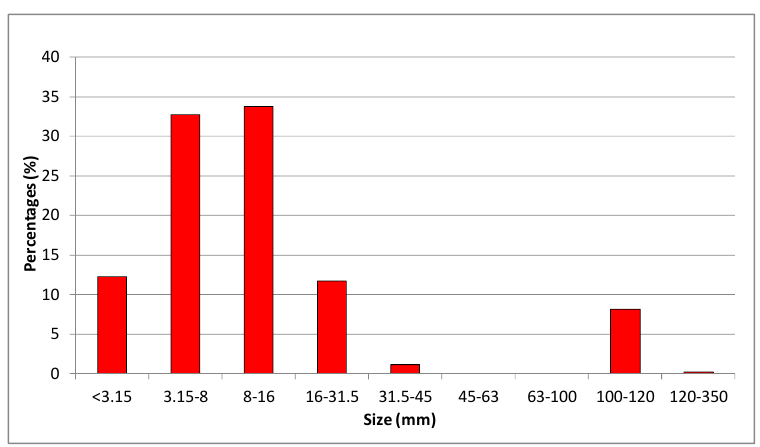
Figure 3. Particle size distribution analysis of the hog fuel produced by the Caravaggi mod. BIO900. The d50 value (median value of the cumulated distribution curve) is 9.17 mm (Figure 4 and Table 2).